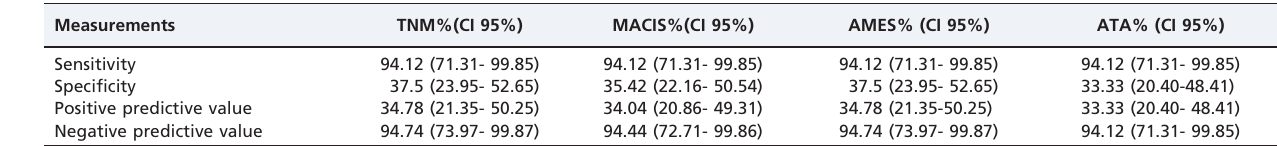
Table 3 - Accuracy and the staging system on predicting good response to initial therapy.